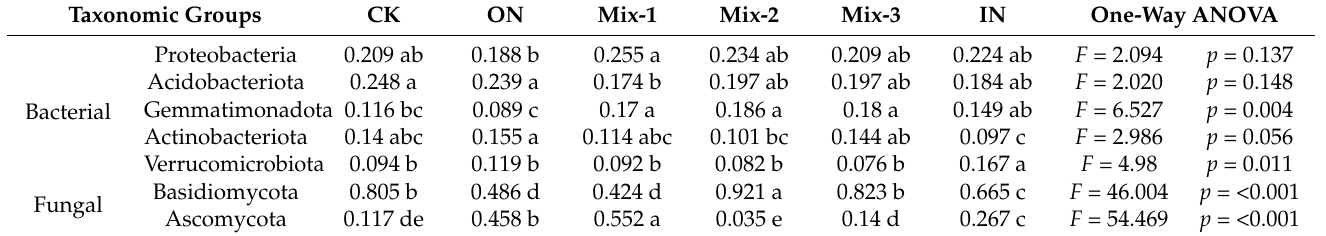
Table A1. Relative abundance of the dominant bacteria phylum and fungi phylum in different treatments. Different lowercase letters indicate significant differences between treatments ( p < 0.05).